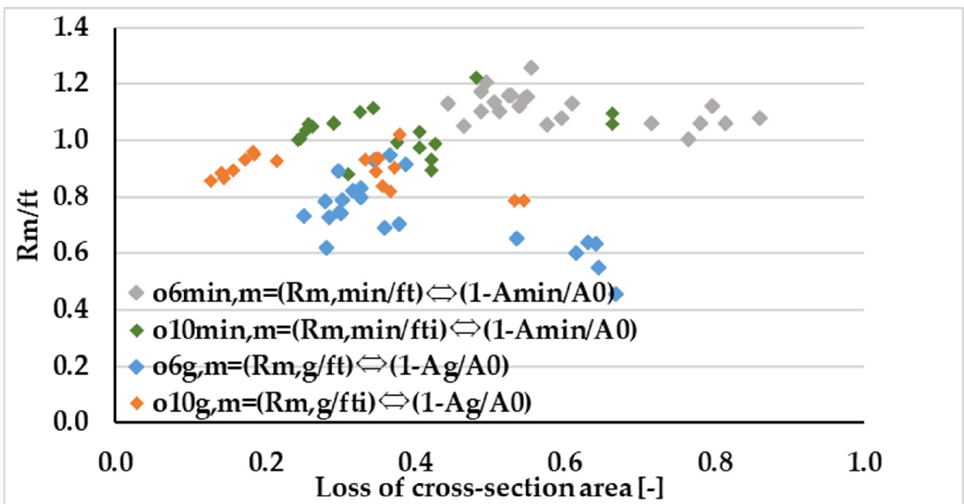
Figure 19. Dependence of the tensile strength ratio of the corroded (R m,g /f t ) and non-corroded sample (R m,min /f t ) on the relevant loss of cross-sectional area of reinforcement ((1 − A g /A 0 ) or (1 − A min /A 0 ))—comparison ϕ 6 and ϕ 10.